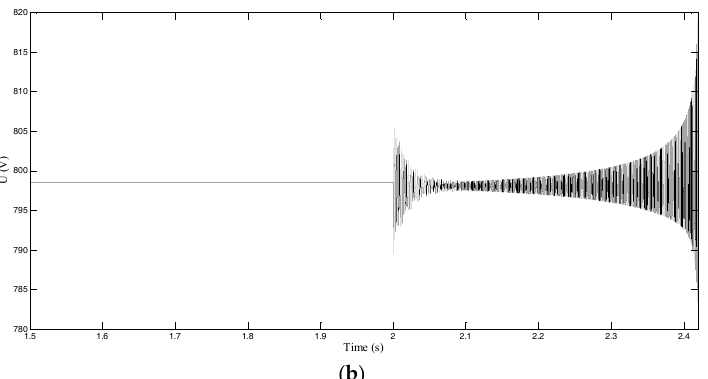
Figure 5. Simulation waveform of U dc : ( a ) changing P s1 from 50 kW to 80 kW at t = 2 s; and ( b ) changing P s1 from 50 kW to 90 kW at t = 2 s.